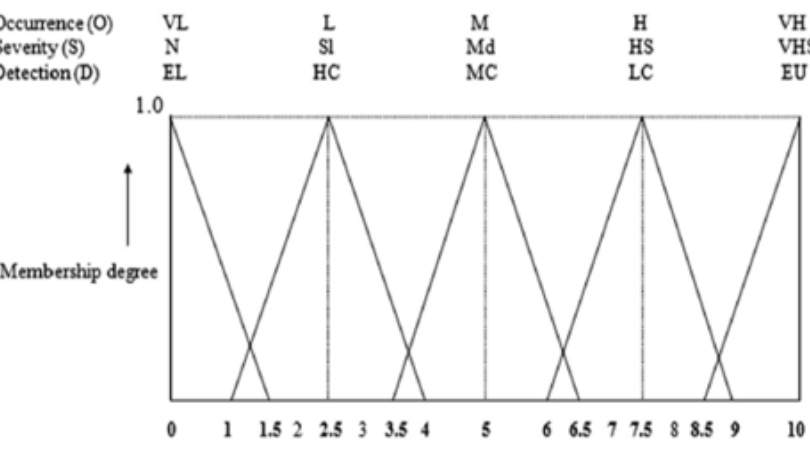
Figure 13. Fuzzy linguistic membership function for severity, occurrence, and